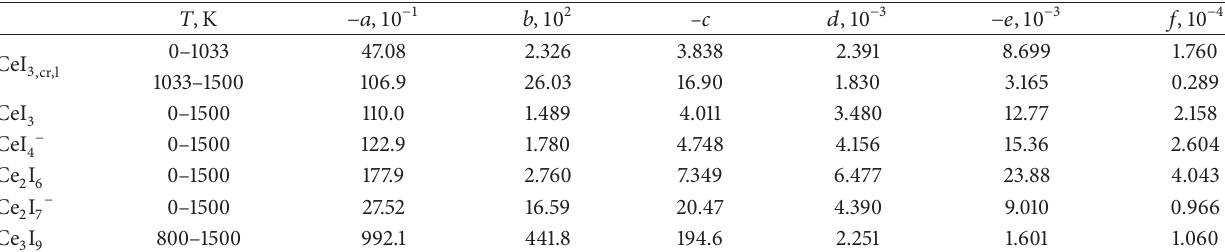
Table 10: Coefficients of polynomial